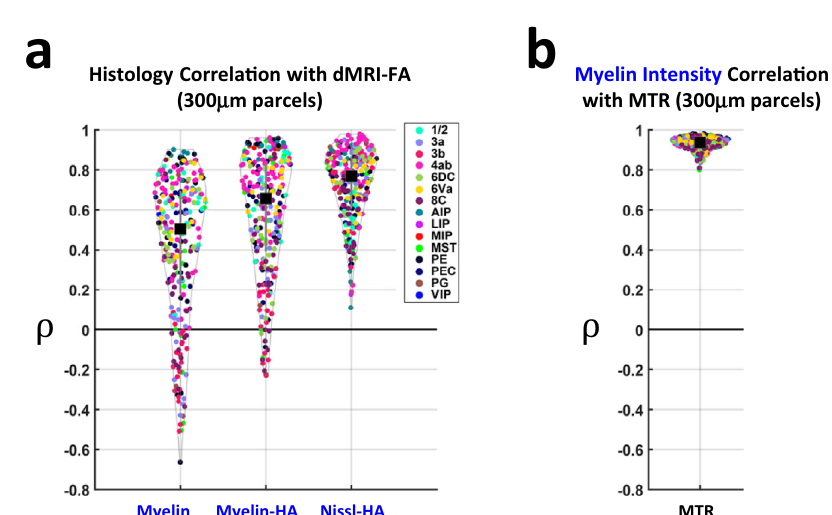
Fig. 4 | The distribution of correlation coef fi cients between histological para- meters and dMRI-FA overall 393 parcels of cortex. a correlations of histology variables to dMRI-FA, Myelin: min − 0.66, Q1 0.18, median 0.47, Q3 0.69, max 0.9; Myelin-HA:min − 0.23,Q10.39,median0.64,Q30.83,max0.96;Nissl-HA:min0.11, Q10.61, median0.76,Q30.87, max0.98. b CorrelationofMTRto MyelinIntensity: min 0.8, Q1 0.91, median 0.94, Q3 0.96, max 0.98. Each point in the distribution is